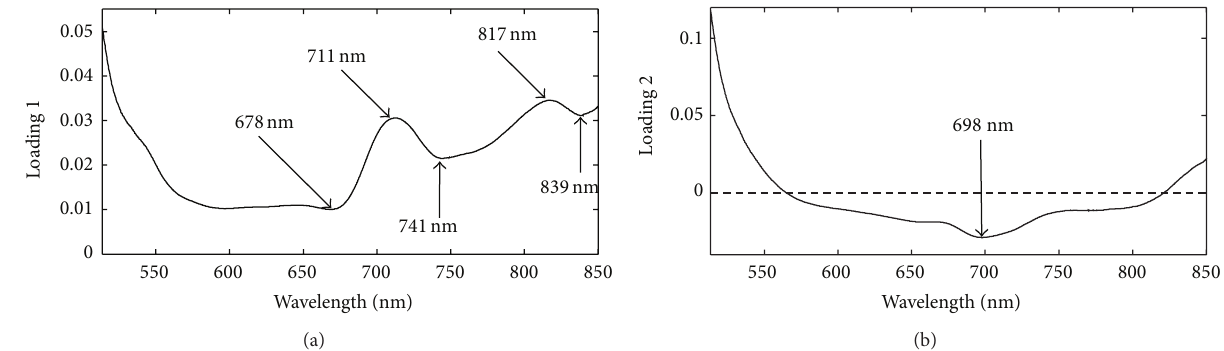
Figure 6: Wavelengths selection from loadings of the first two principal components derived from PCA: (a) loading 1; (b) loading 2.